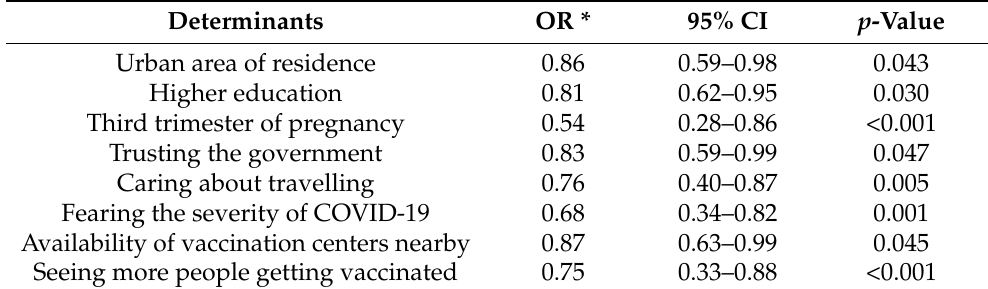
Table 6. Analysis of determinants for COVID-19 vaccine acceptance among pregnant